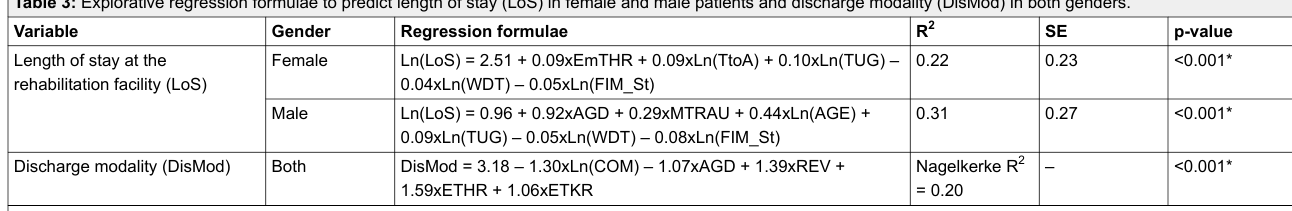
Discharge to “home” Discharge to “other setting” (DisMod = 1) (DisMod = 0)